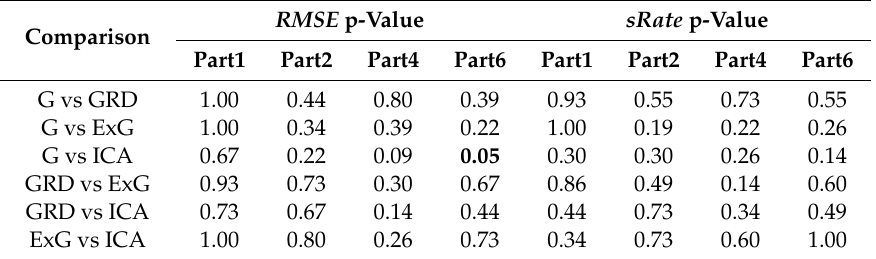
Table A8. The Wilcoxon rank sum test results (p-values) for comparing di ff erent signal extraction methods and activities, algorithm No.2 (AR).